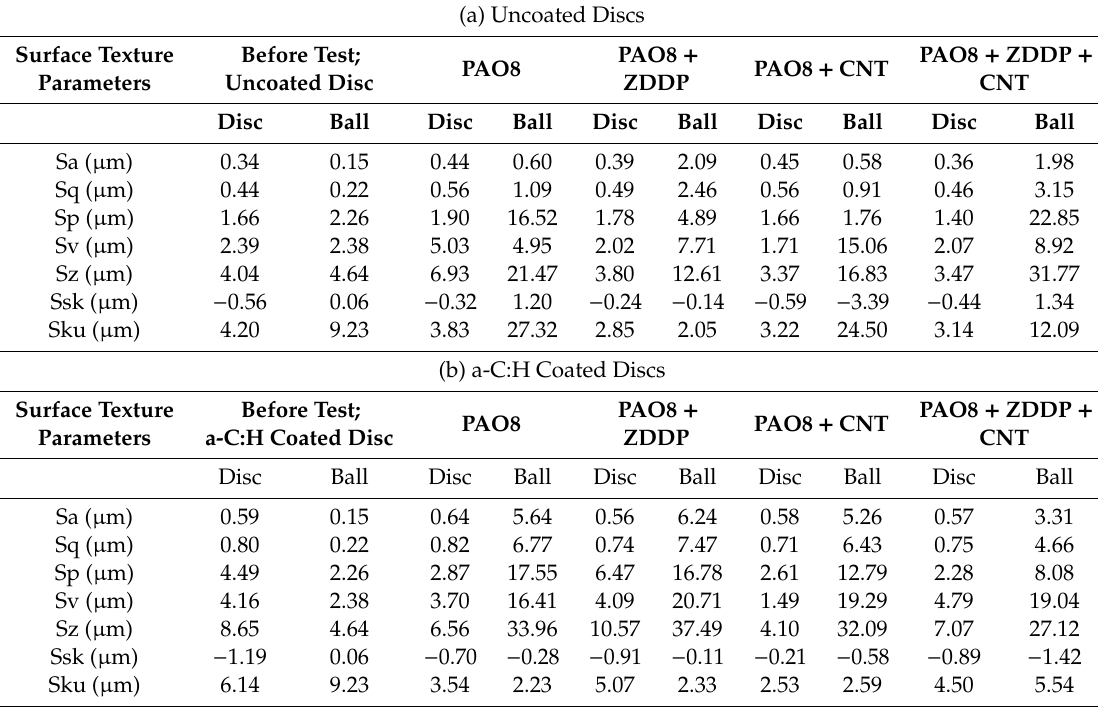
Ball Ball Disc Ball